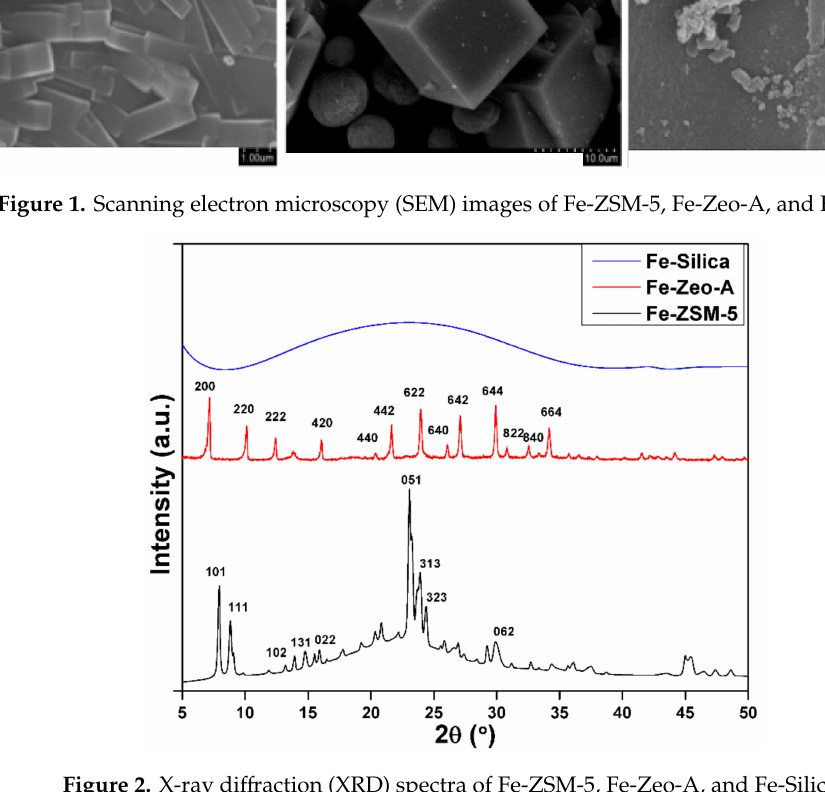
Figure 2. X-ray di ff raction (XRD) spectra of Fe-ZSM-5, Fe-Zeo-A, and